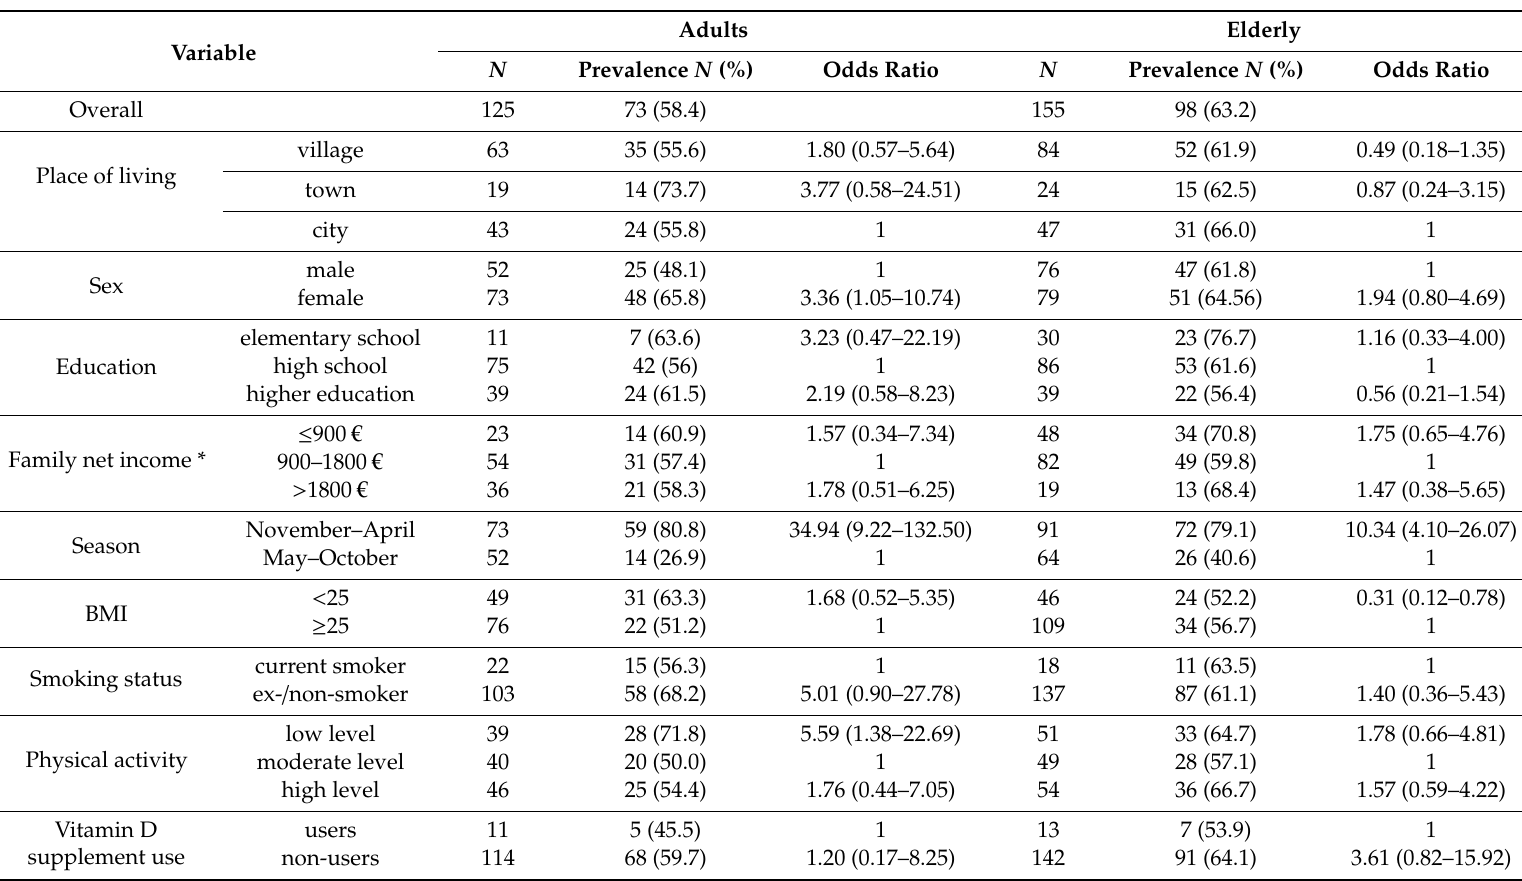
Table 4. Sample prevalence of serum 25(OH)D levels below 50 nmol / L, and adjusted odds ratios (95% CI) for adult (18–64 years) and elderly (65–74 years)